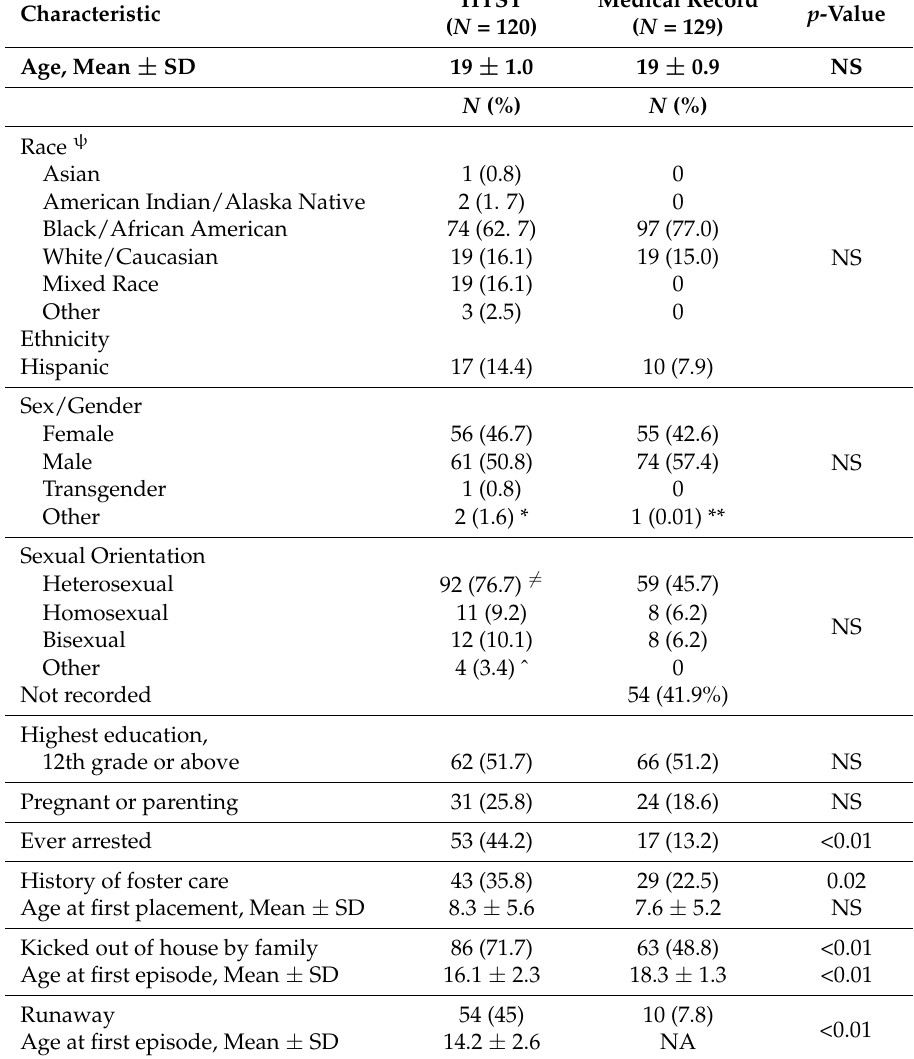
Table 1. Sample characteristics reported on the Human Trafficking Screening Tool (HTST) versus medical record